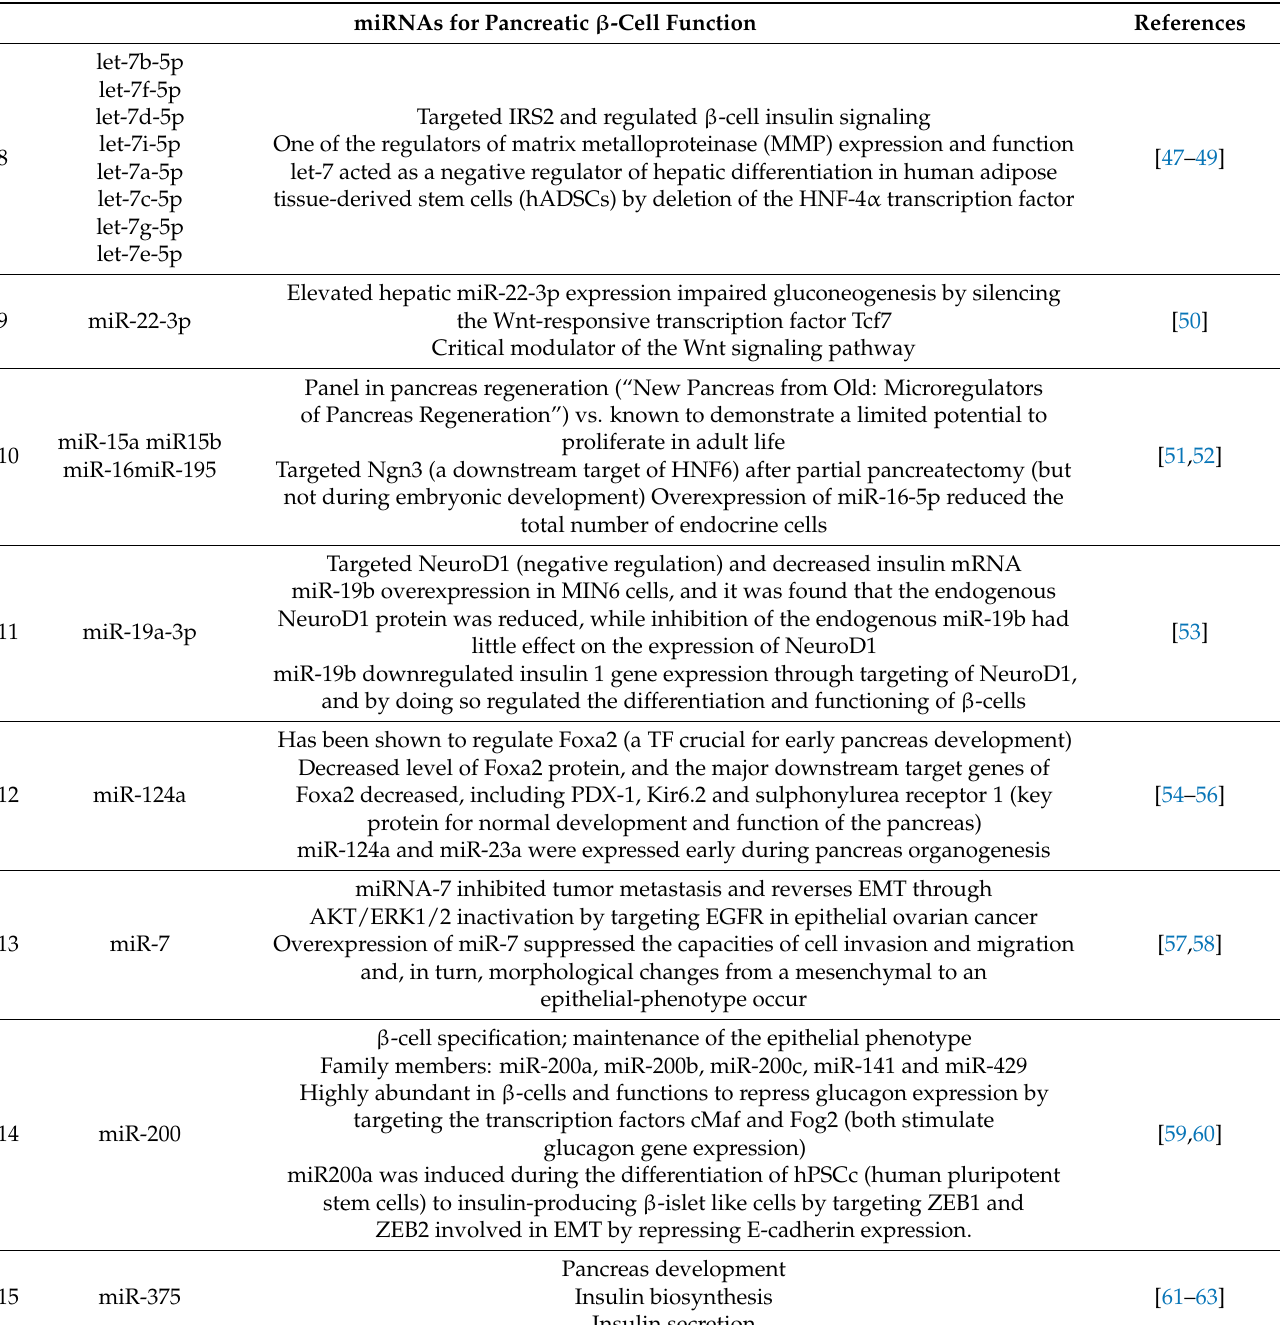
Table 1. Cont. miRNAs for Pancreatic β -Cell